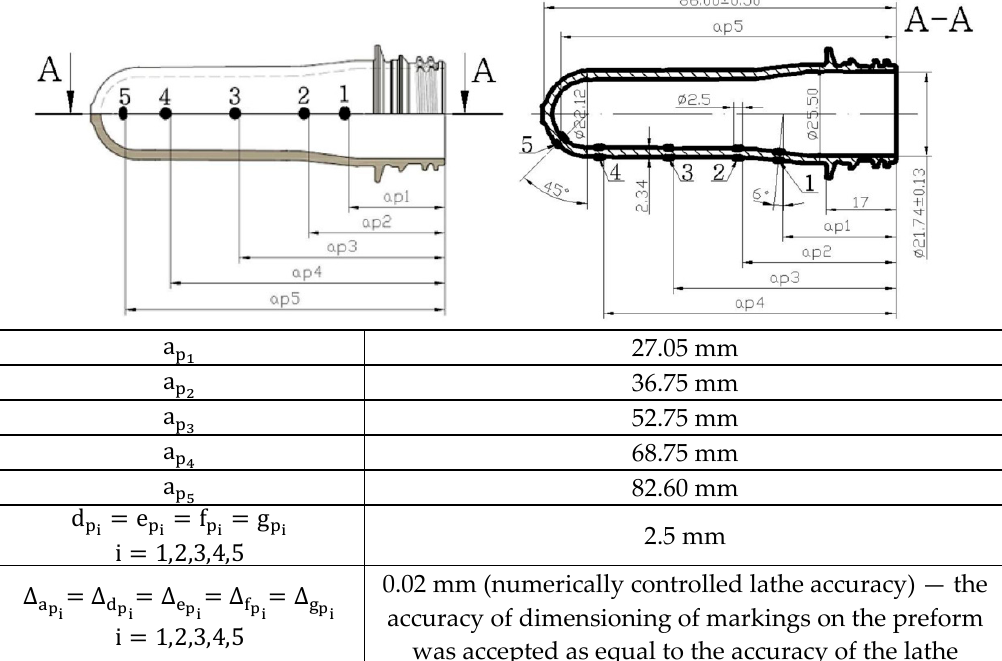
Figure 5. The shape of the analyzed bottle and the location of individual measuring points of the bottle wall thickness, also showing the area of thickness measurements around the measuring points for the example of point I-3 (explanation in Figure A1). The determination of the axial position of the point will be explained in the second part of this article. In Formula (A1), the problem is to determine the extension factor “k” because it has a value resulting from the accepted level of confidence and the distribution resulting from the composition of normal distribution (type A uncertainty) and uniform distribution (type B uncertainty). The resultant distribution is a convolution of the constituent distributions and its determination creates many problems. For this reason, a method enabling an approximate determination of the expansion coefficient should be used, which is based on the assumption that the resultant distribution coincides with a distribution with a larger standard deviation [26]. If (uncertainty of type A) > (uncertainty of type B), then the expansion coefficient assumes the values of a standardized random variable of the normal distribution (or t-Student). If (uncertainty of type A) < (uncertainty of type B), then the coefficient k assumes the values characteristic of a uniform distribution. It was assumed in the study that for all cases the value of the coefficient “k” is equal to 2. Figure 6 shows how to measure the dimensions that are the basis of the bottle to define the coefficients of the bottle blowing kinetics. The bottle blowing kinetics coefficients have been defined as the quotient of the kinetics coefficients of the bottle (Figure 6) by the corresponding kinetics coefficients of the preform (Figures 3 and 4). The coefficients of the bottle blow kinetics were calculated on the basis of the dimensions shown in Figure 6, and their formulas are shown in Equations (A2), (A4), (A6), (A8), (A10), (A12), and (A14). Equations (A2)–(A21) lists the coefficients of the bottle blowing kinetics, and the method calculating them on the basis of the measurement variables (a, p1, p2, p3, e, f), along with showing how to calculate the most likely measurement uncertainty value for the coefficients of the bottle blow kinetics (A3), (A5), (A7), (A9), (A11), (A13), and (A15), respectively.